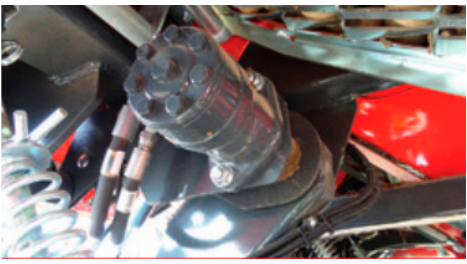
Figure 31. Hydraulic drive motor. Reprinted with permission from ref. [90] Copyright 2022 Grimme Industries.